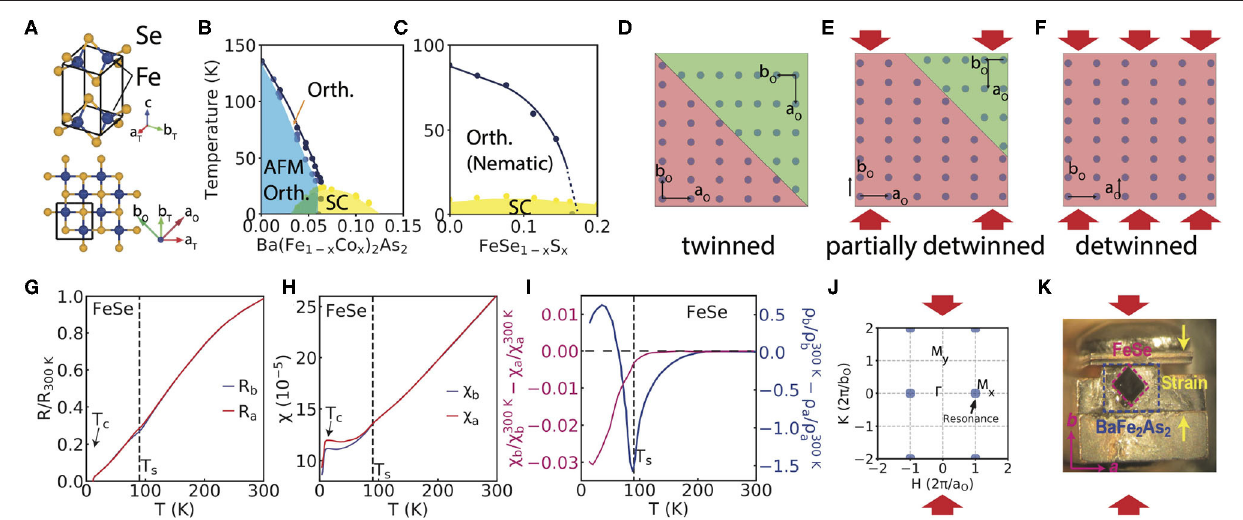
FIGURE 1 | Crystal strucutres, phase diagrams of FeSe, schematic of detwinning process, basic properties and photo of a detwinning device. (A) Crystal structure of FeSe and the collinear AF structure in the Fe plane of FeSe. (B) Phase diagram of Ba(Fe 1 − x Co x ) 2 As 2 [12]. (C) Phase diagram of FeSe 1 − x S x [13]. (D–F) Schematic illustration of a twinned (D) , partially detwinned (E) , and fully detwinned (F) single crystal that contains two domains under a zero (D) , intermediate (E) , and large (F) mechanical force. (G) Temperature dependence of in-plane resistivity R a ( ρ a resistivity along a direction) and R b ( ρ a resistivity along b direction) of FeSe. (H) Temperature dependence of in-plane susceptibility χ a and χ b (susceptibility along a and b directions) of FeSe in a 12 T field. (I) Anisotropy of resistivity and susceptibility of FeSe [14]. (J) Schematic of the Brillouin Zone (BZ). The strain direction is along b-axis, defining the Ŵ - M Y momentum direction in the ARPES measurements. Blue dots mark the AF wave-vector in the BZ. (K) Photo of a detwinning device [15]. The mechanical uniaxial strain device consists of a clamp that presses a single crystal substance of BaFe 2 As 2 , which can transfer the strain to the single crystal of FeSe glued on top. The strain direction is along b-axis, defining the Ŵ - M Y momentum direction. Panels (G–I) are reproduced from [14] with